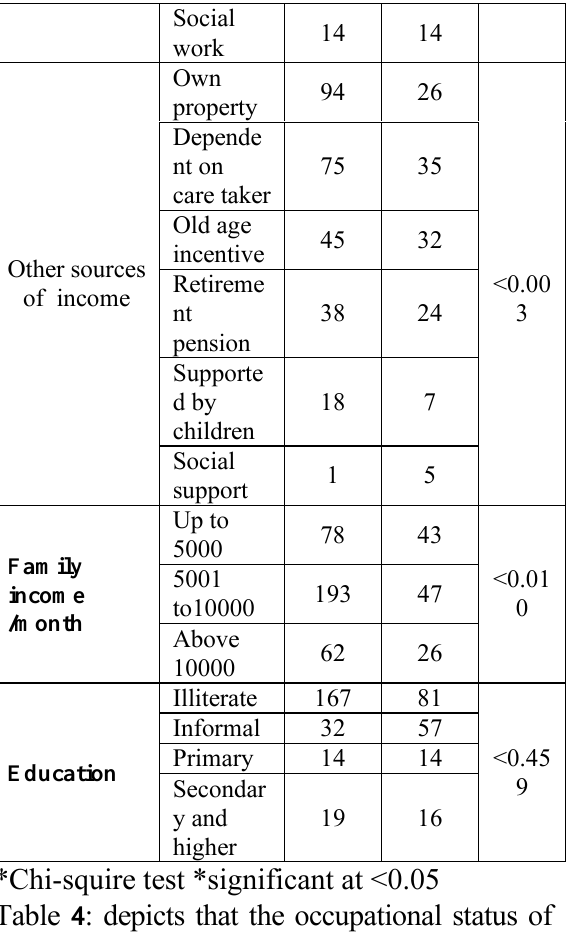
Table 5: shows that severity of illness